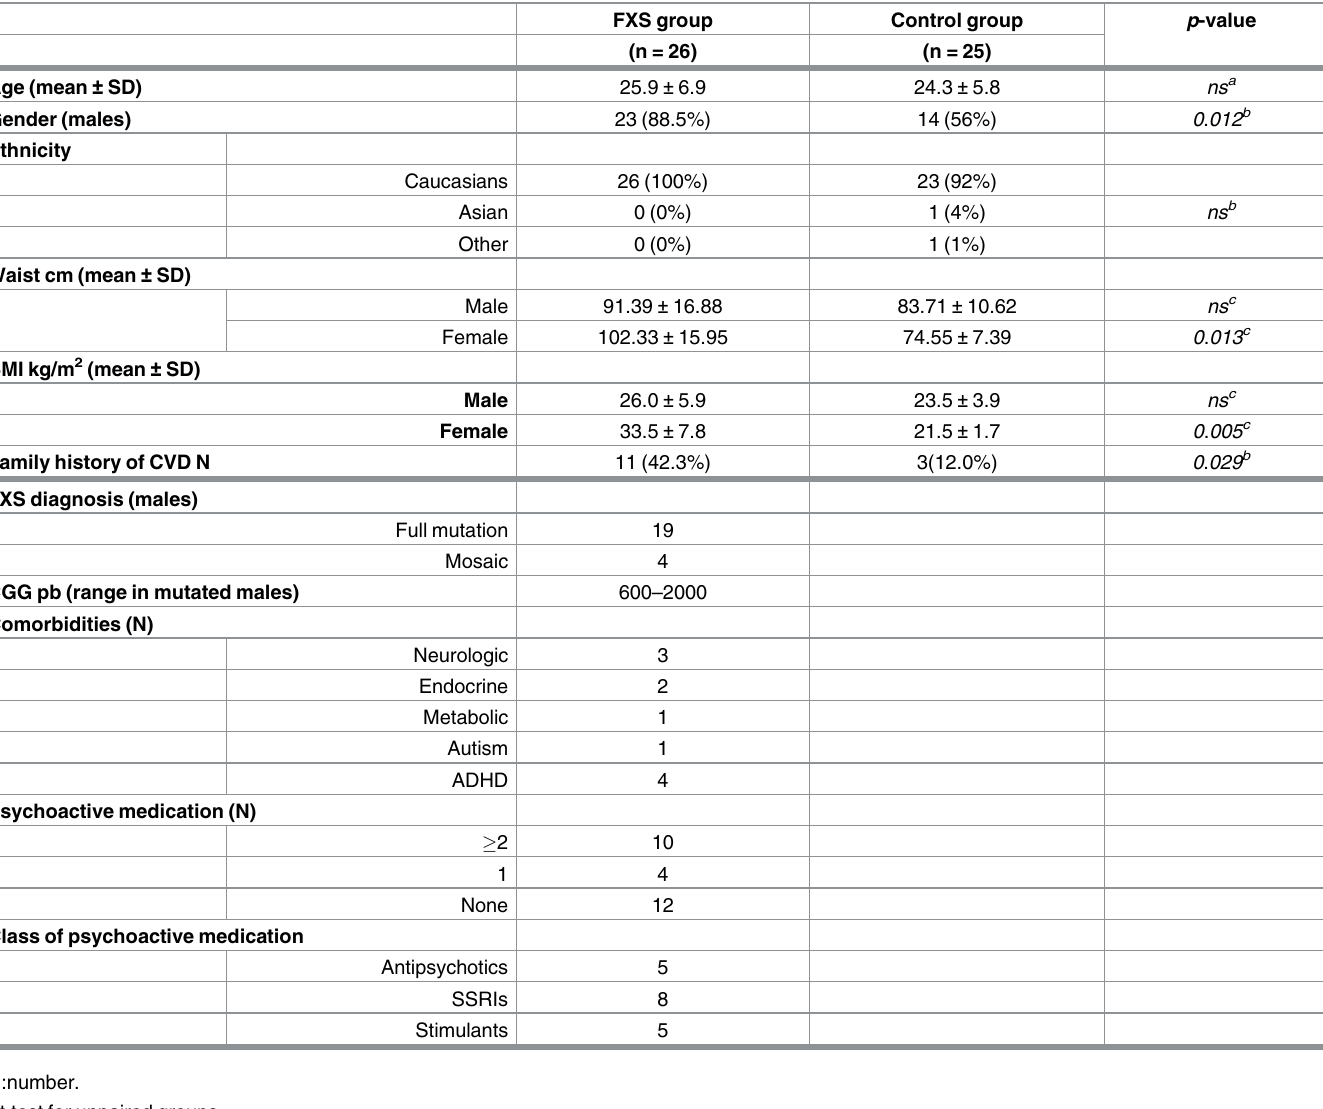
Table 1. Population